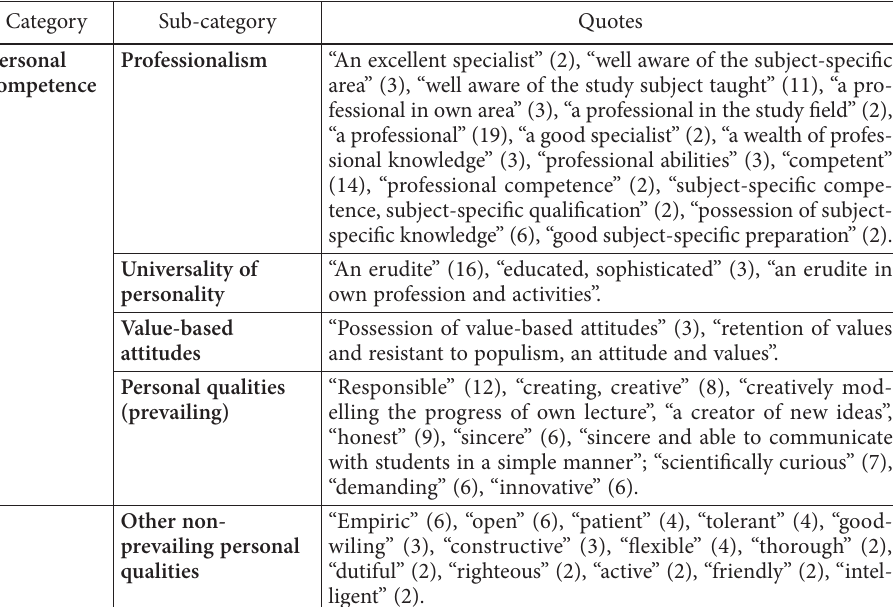
Table 1. The category of personal competence, its subcategory and substantiating quotes (source: created by authors)